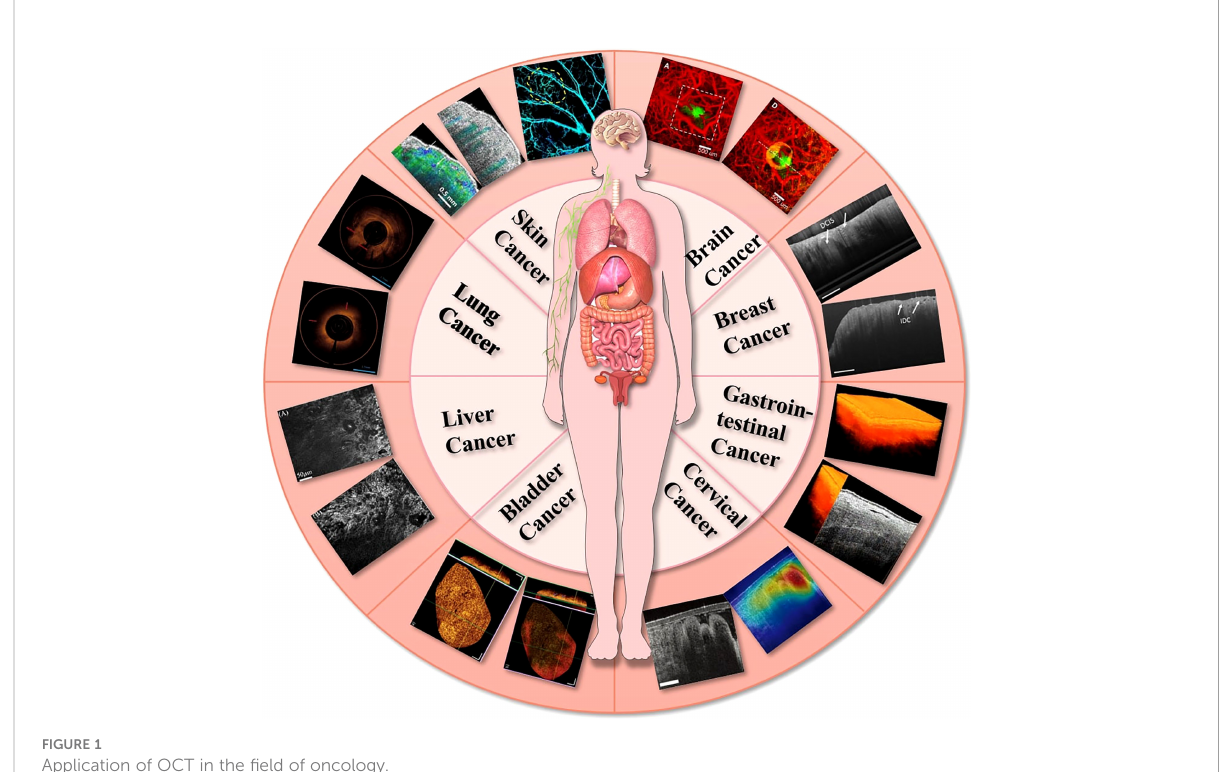
FIGURE 1 Application of OCT in the fi eld of oncology.